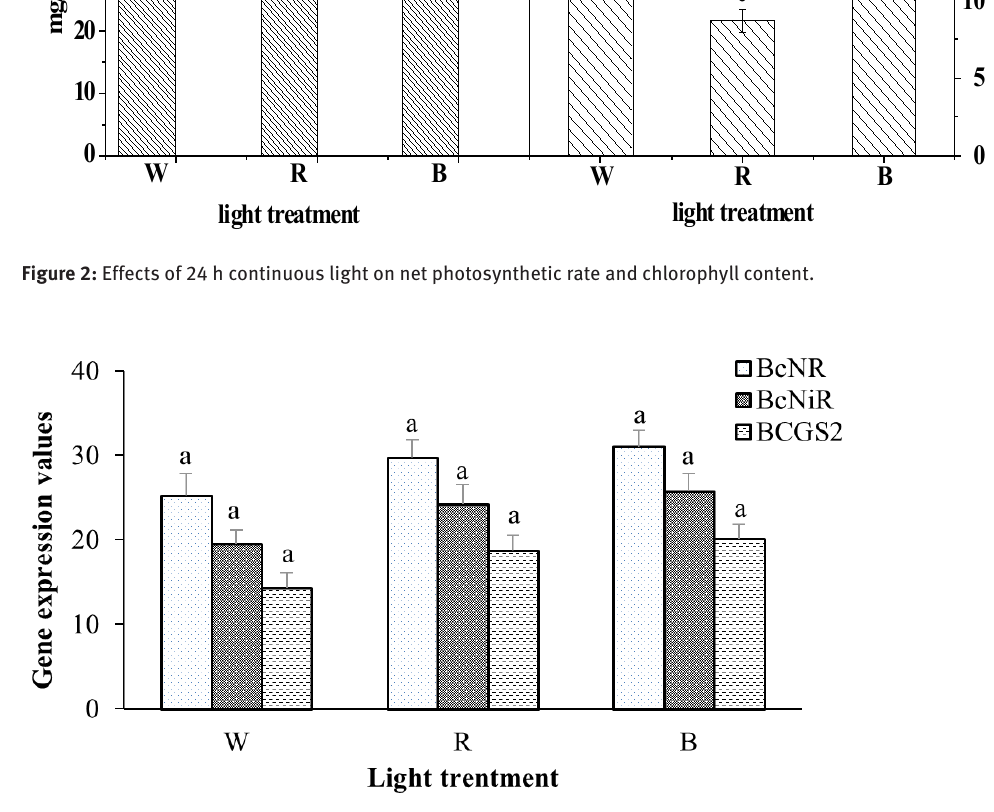
Figure 3: Effects of 24 h continuous light on key nitrogen metabolism gene gene expression in